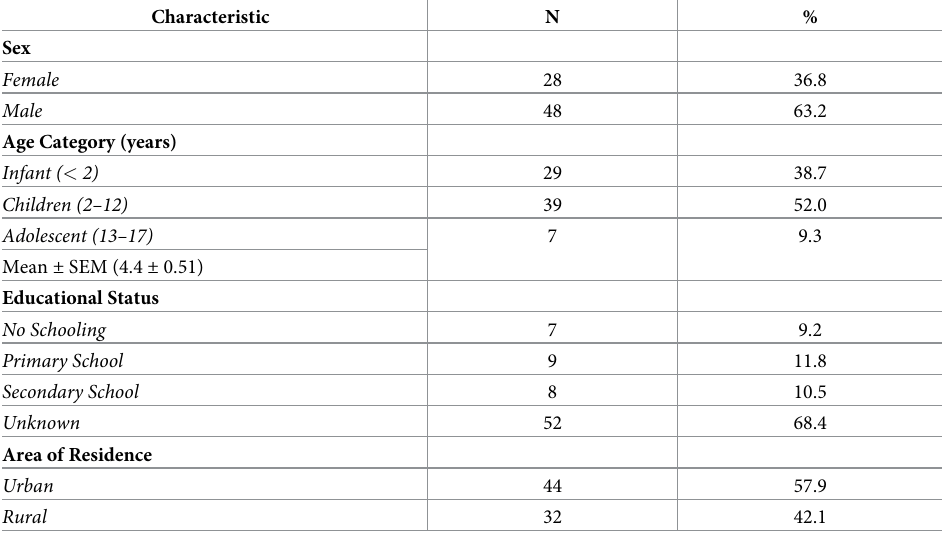
Table 1. Demographic characteristics of the pediatric patients with diarrhea.